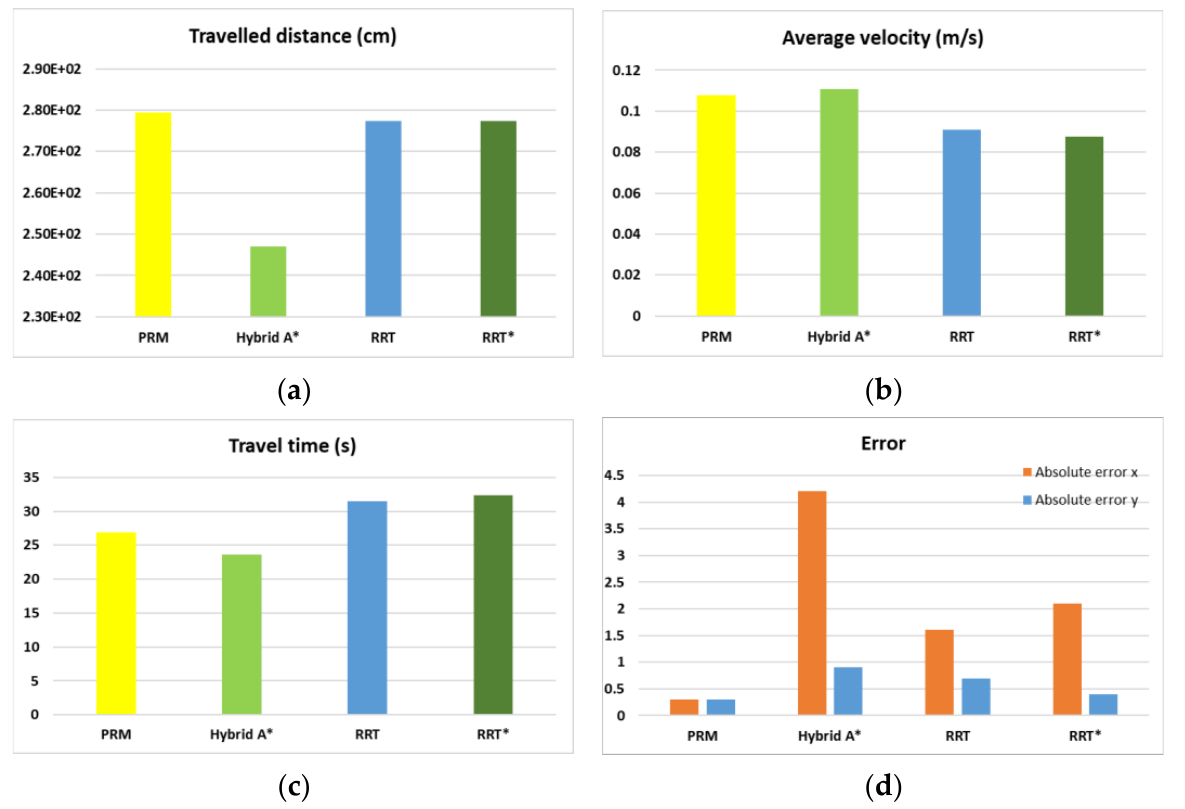
Figure 15. The experimental results that are generated by using different path-planning techniques in Map2. ( a ) The resultant traveled distance for different path planning techniques. ( b ) The resultant average velocity for different path planning techniques. ( c ) The resultant travel time for different path planning techniques. ( d ) The resultant absolute error for different path planning techniques.